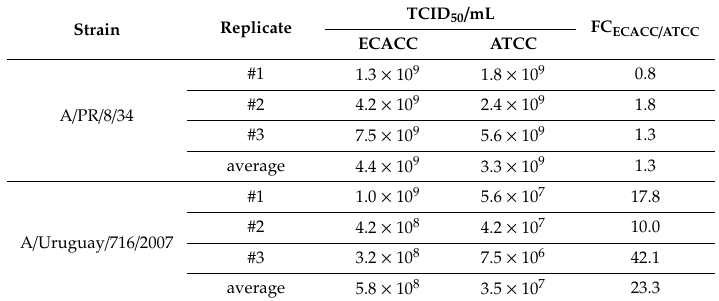
Table A2. Maximum tissue culture infective dose (TCID 50) titers obtained during the production of influenza virus strains in suspension cultures with MDCK cells derived from ATCC and ECACC.